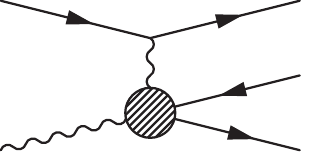
5. Feynman diagram for the direct trident process used for the Weizsäcker-Williams calculation. The incoming wavy line represents the coherent interaction of many particles — described as a homogeneous field — with the